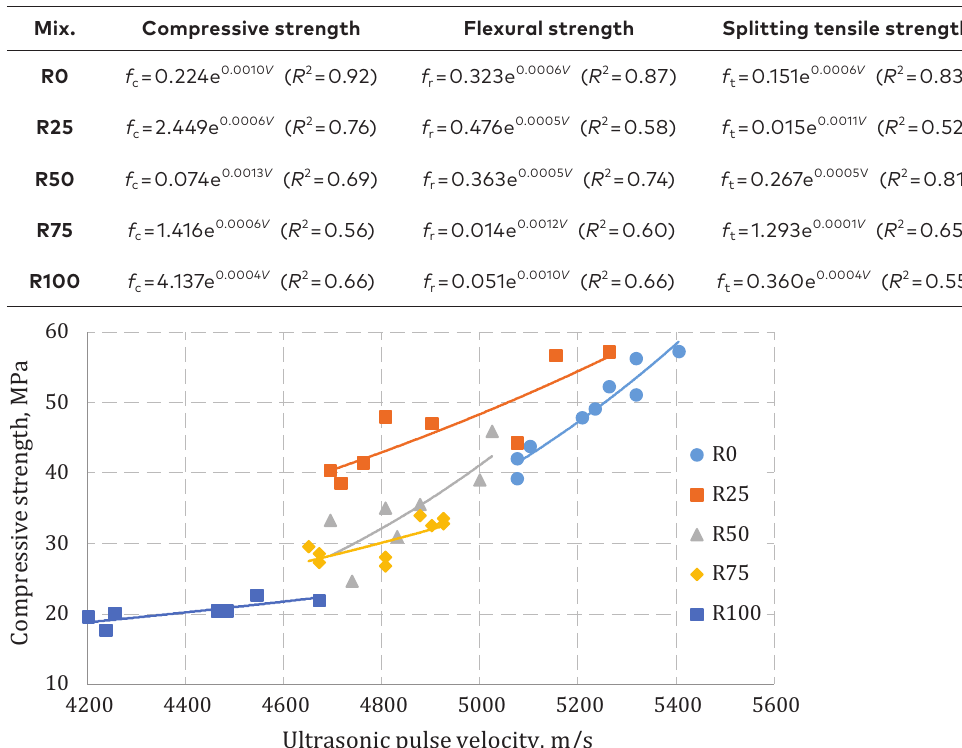
Figure 12. Compressive strength-UPV